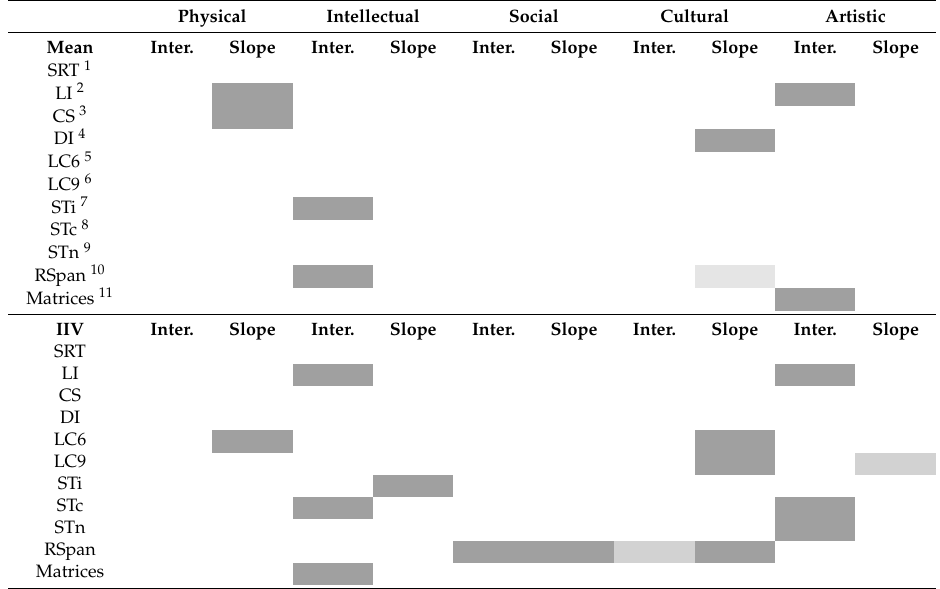
Table 4. Synthesis of significant relationships between activity type and cognitive performance at baseline and subsequent change (mean performance and IIV). Physical Intellectual Social Cultural Artistic Mean Inter. Slope Inter. Slope Inter. Slope Inter. Slope Inter. Slope SRT 1